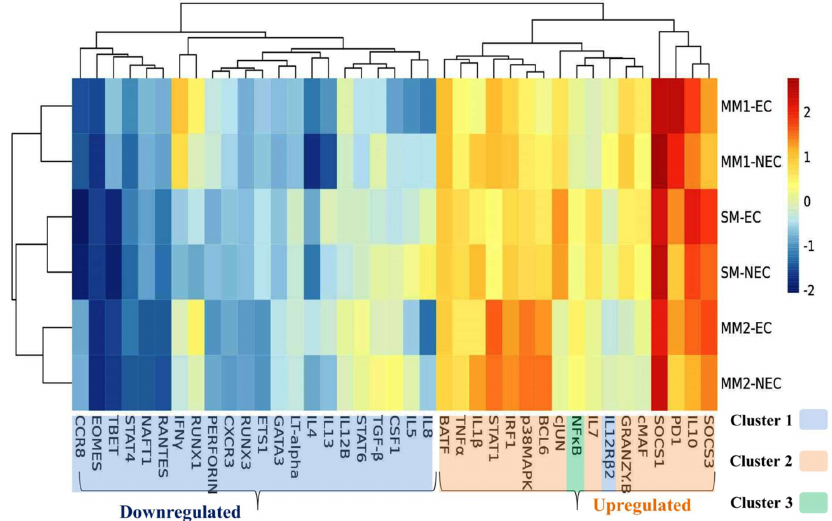
Figure 5. Heat-map illustrates comparative fold change of each group per gene expression profile. Each cell of the 2D plot denotes log2 fold value of a single factor in one group with standardized levels represented by color as per color scale on the right. Fold change was calculated by 2 − ∆∆ Ct method considering β -actin as an endogenous control. Top horizontal and left vertical dendrogram indicates average Euclidean clustering of genes taken into panel and malaria clinical subgroups, respectively. UC1 was marked and sub-grouped from the UC2 and SM group. The figure shows a consequence of higher parasitic burden displayed by the latter two groups despite other reasonable associated causes.